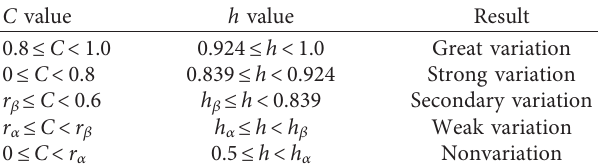
Table 1: Classification table of the variation degree.